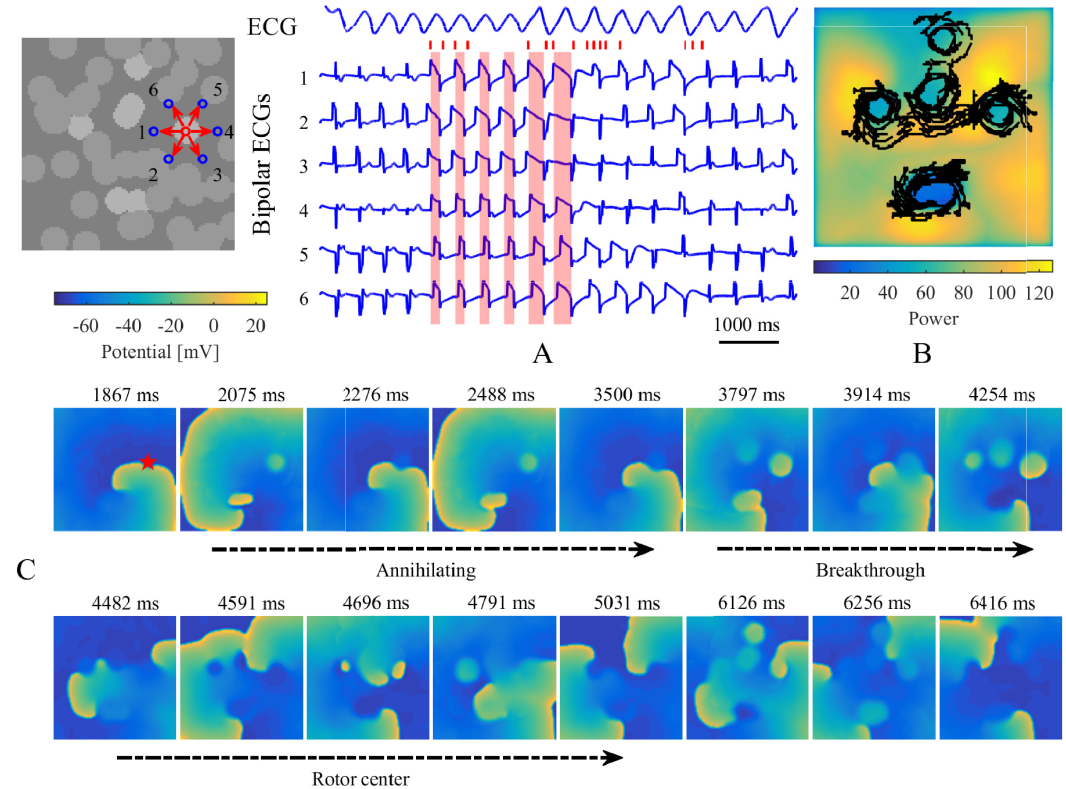
Fig 12. Electrogram characteristics and PS trajectories for a stable simulation without intramural re-entry. (A) Simulated ECG and bipolar electrograms recorded around a myocardial patch on the endocardium sheet. Blue circles and red arrows denote the recording sites and directions of bipolar electrograms. Bipolar electrograms covered in red shadows represent some sections from the local maximums to local minimums of No. 1 bipolar electrograms. Red tags successively denote the corresponding times of (C) transmembrane potential maps in the endocardium sheet. Red star denotes this patch location on the transmembrane potential maps. (B) The maximum map of power spectrum for every unipolar electrogram. Black lines denote the trajectories of phase singularities during the whole